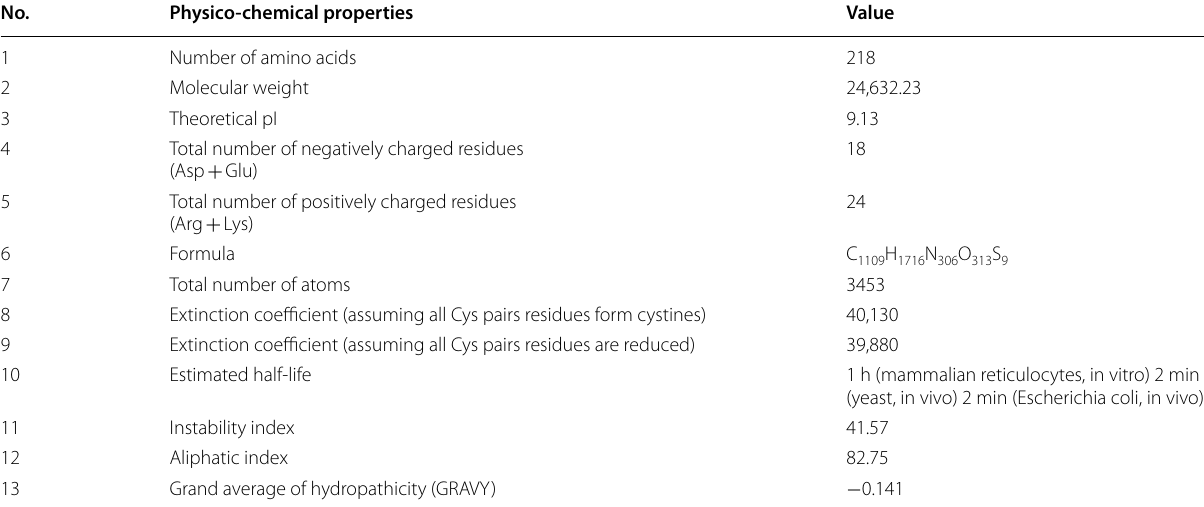
Table 1 Physiochemical parameters of Y-domain